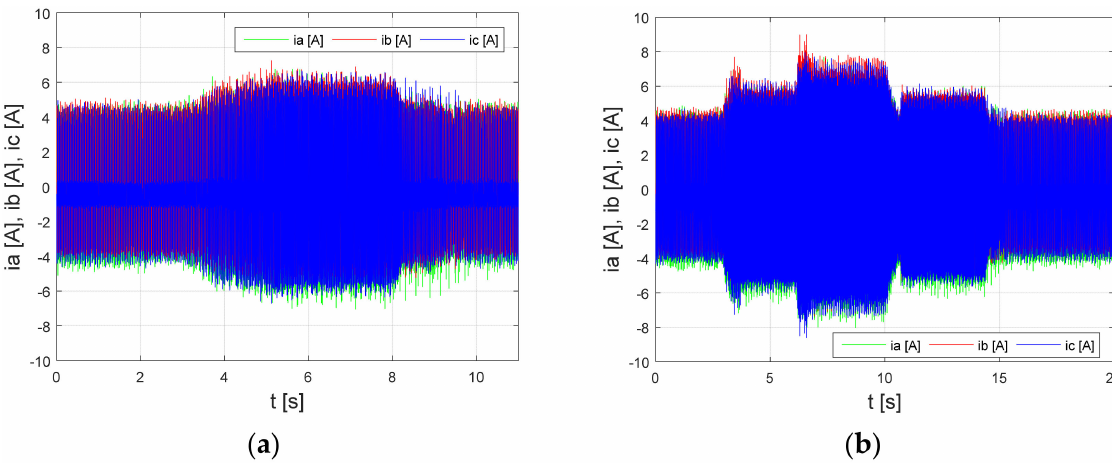
Figure 22. Motor-pump assembly phase-current waveforms: ( a ) Single speed ramp; ( b ) Double speed ramp.